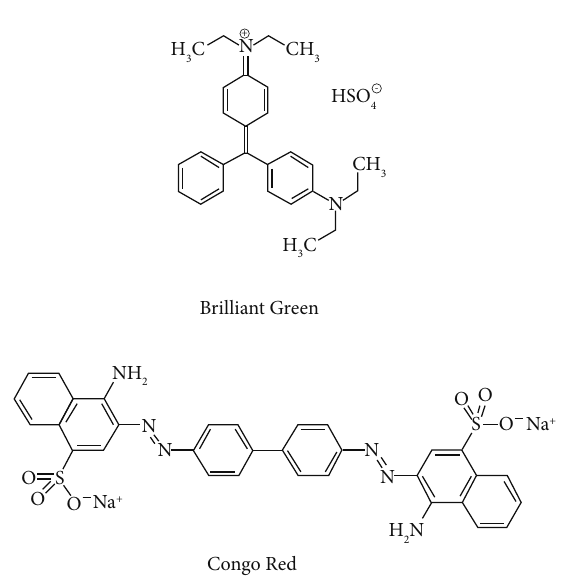
Figure 1: Structural formulas of brilliant green (BG) and Congo red